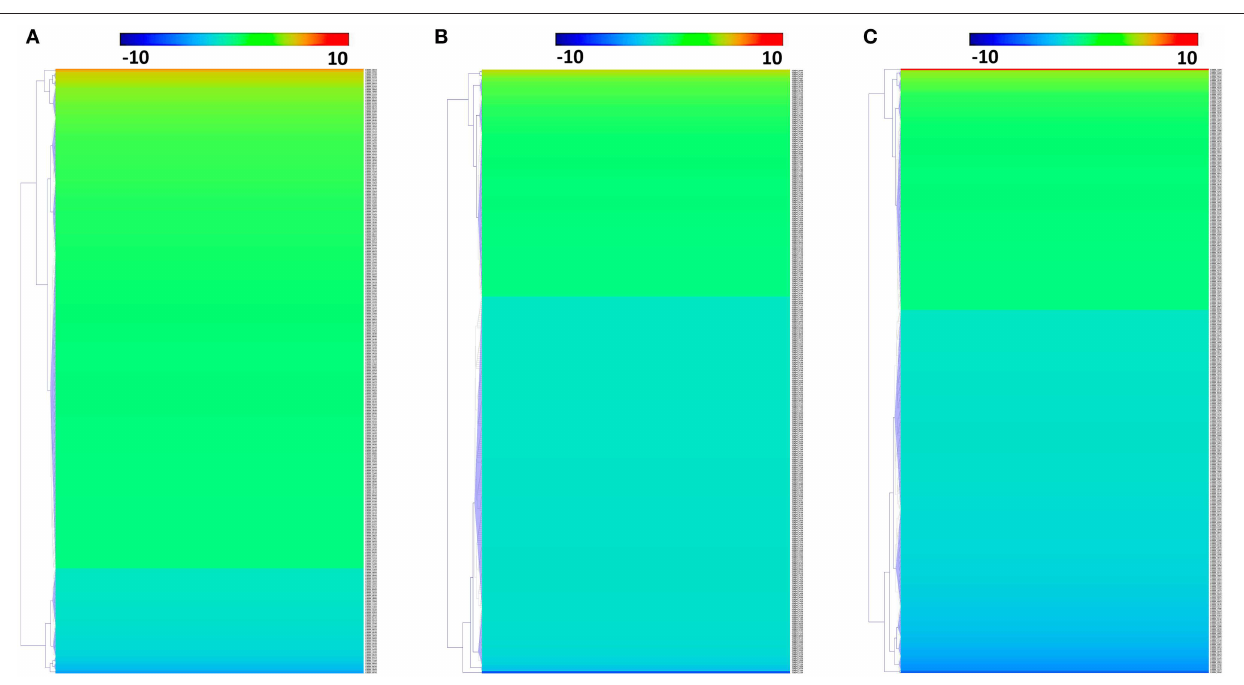
FIGURE 4 | Hierarchical clustering heat maps of differentially expressed phosphoproteins (DEPs). Expression values of DEPs were log1.5-transformed. (A–C) Represent heat maps of phosphoproteins up/down-regulated in RH strain when comparing RH/PRU strains, in PRU strain when comparing PRU/PYS strains, and in PYS strain when comparing PYS/RH strains,